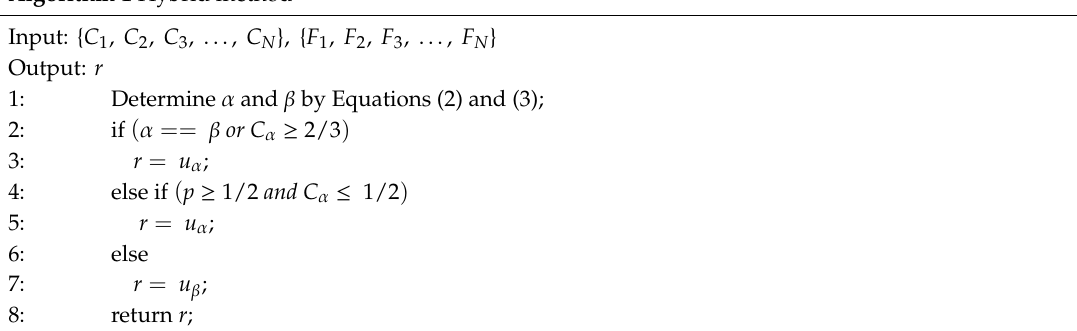
Algorithm 1 Hybrid